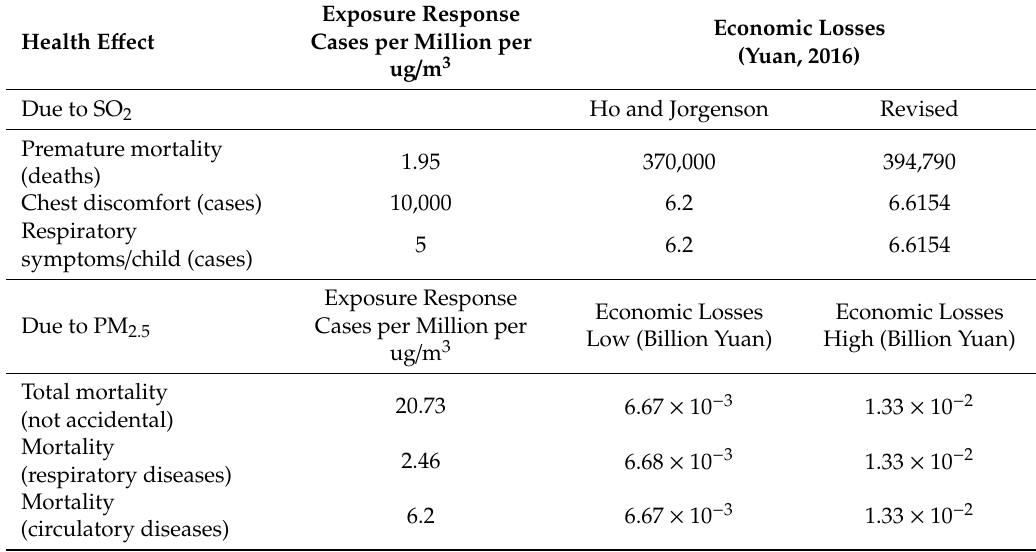
Table 1. Measures of exposure response and health e ff ects of SO 2 and PM 2.5